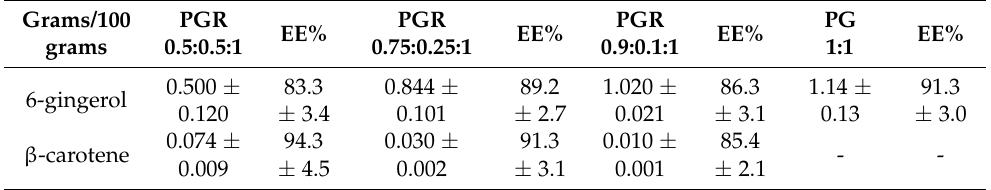
Table 5. Drug loading and encapsulation efficiency (%) in PHYTOGINROSA (PGR) and PHYTOGIN (PG)